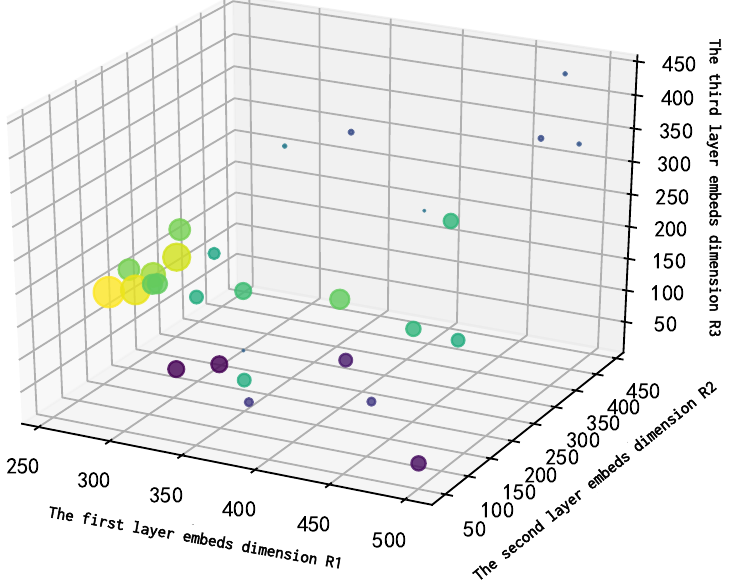
Figure 2. Analysis of the embedding dimension relationship of different layers. Figure 3a–c shows the performance of the NMI as these parameters change.